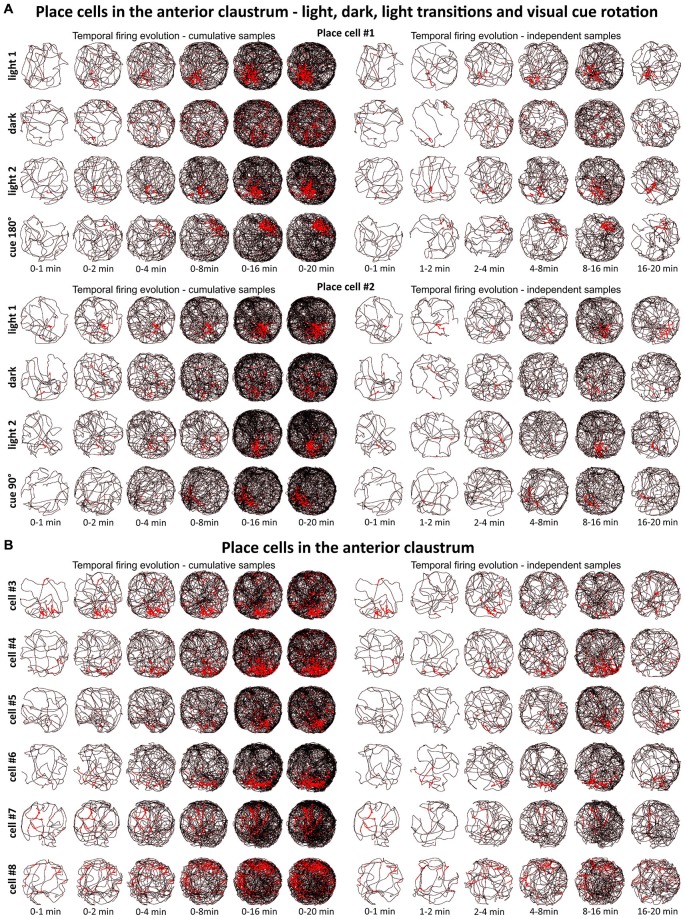
Temporal evolution of firing of claustral place cells. (A) Temporal evolution of firing for place cells #1 and #2. Each cell was recorded in the light, darkness, light and after rotation of visual cue in the light. (B) Temporal evolution of firing for place cells #3—#8. For each cell is presented one recording session performed in the light. In both panels (A,B), on the left six samples of cumulative time intervals (0–1, 0–2, 0–4, 0–8, 0–16 and 0–20 min) and on the right six samples of independent time intervals (0–1, 1–2, 2–4, 4–8, 8–16 and 16–20 min) are presented for each cell/condition in the rows. The visual cue was located in the same place as in Figure 1 in baseline conditions.